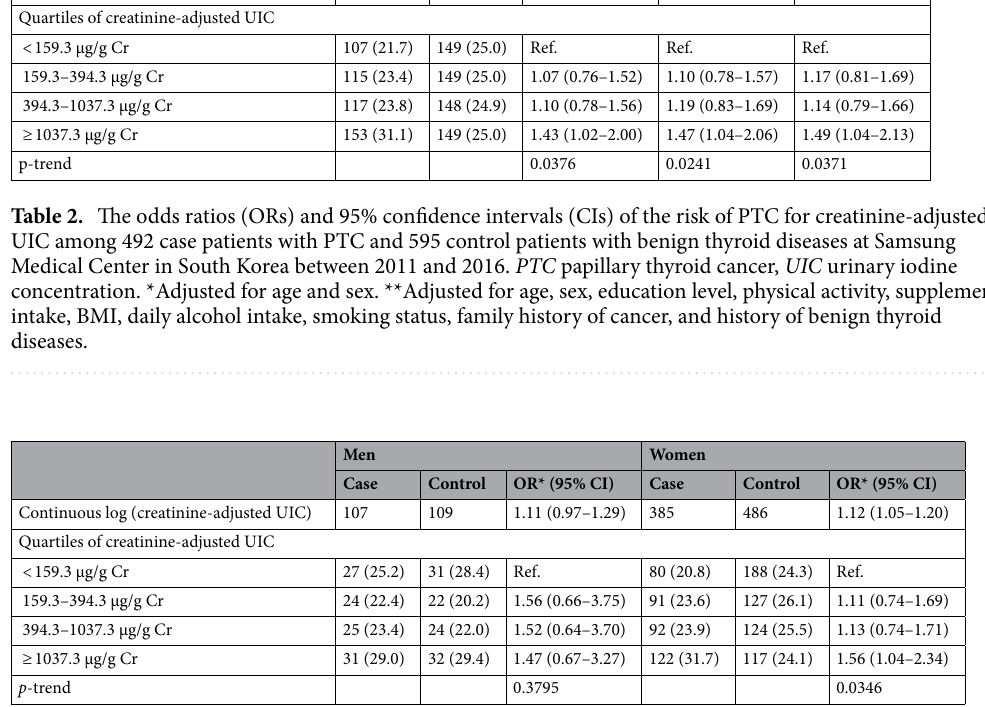
Table 3. The odds ratios (ORs) and 95% confidence intervals (CIs) of the risk of PTC for creatinine-adjusted UIC among 492 case patients with PTC and 595 control patients with benign thyroid diseases stratified by sex. PTC papillary thyroid cancer, UIC urinary iodine concentration. *Adjusted for age, education level, physical activity, supplement intake, BMI, daily alcohol intake, smoking status, family history of cancer, and history of benign thyroid diseases. p for interaction =